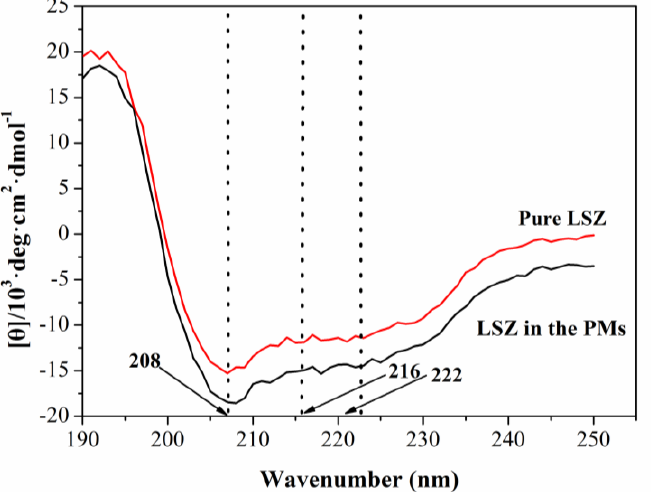
Figure 5. Circular dichroism (CD) spectra of pure LSZ and LSZ from LSZ-PLLA